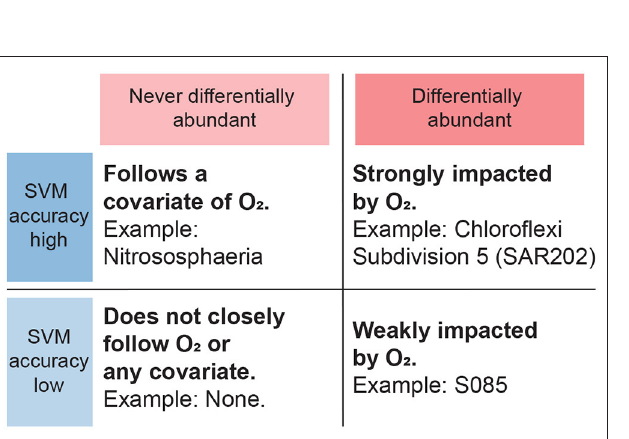
FIGURE 7 | Interpretation of results from SVM and differential abundance analysis combined. Taxa that are never differentially abundant, corresponding to a wide bar on Figure 6 , are taken to not primarily follow the oxygen gradient but instead possibly a corollary, regardless of SVM classification rates. Taxa that are differentially abundant with respect to the oxygen gradient and furthermore achieve high SVM classification rates, are expected to be strongly dependent on